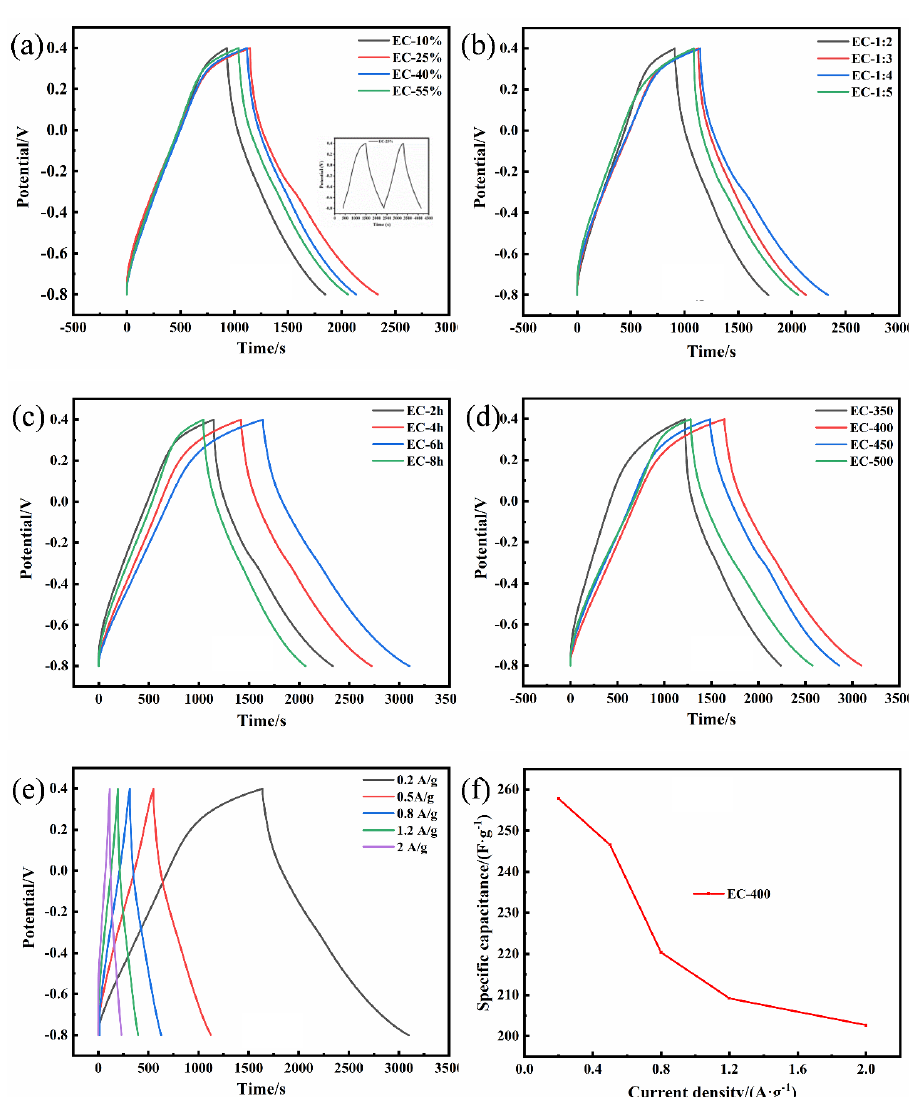
Figure 7. ( a – d ) GCD curve of ECs at 0.2 A · g − 1 ; ( e ) GCD curve of ECs at different current densities; ( f ) the specific capacitance of EC-400 at different current densities.